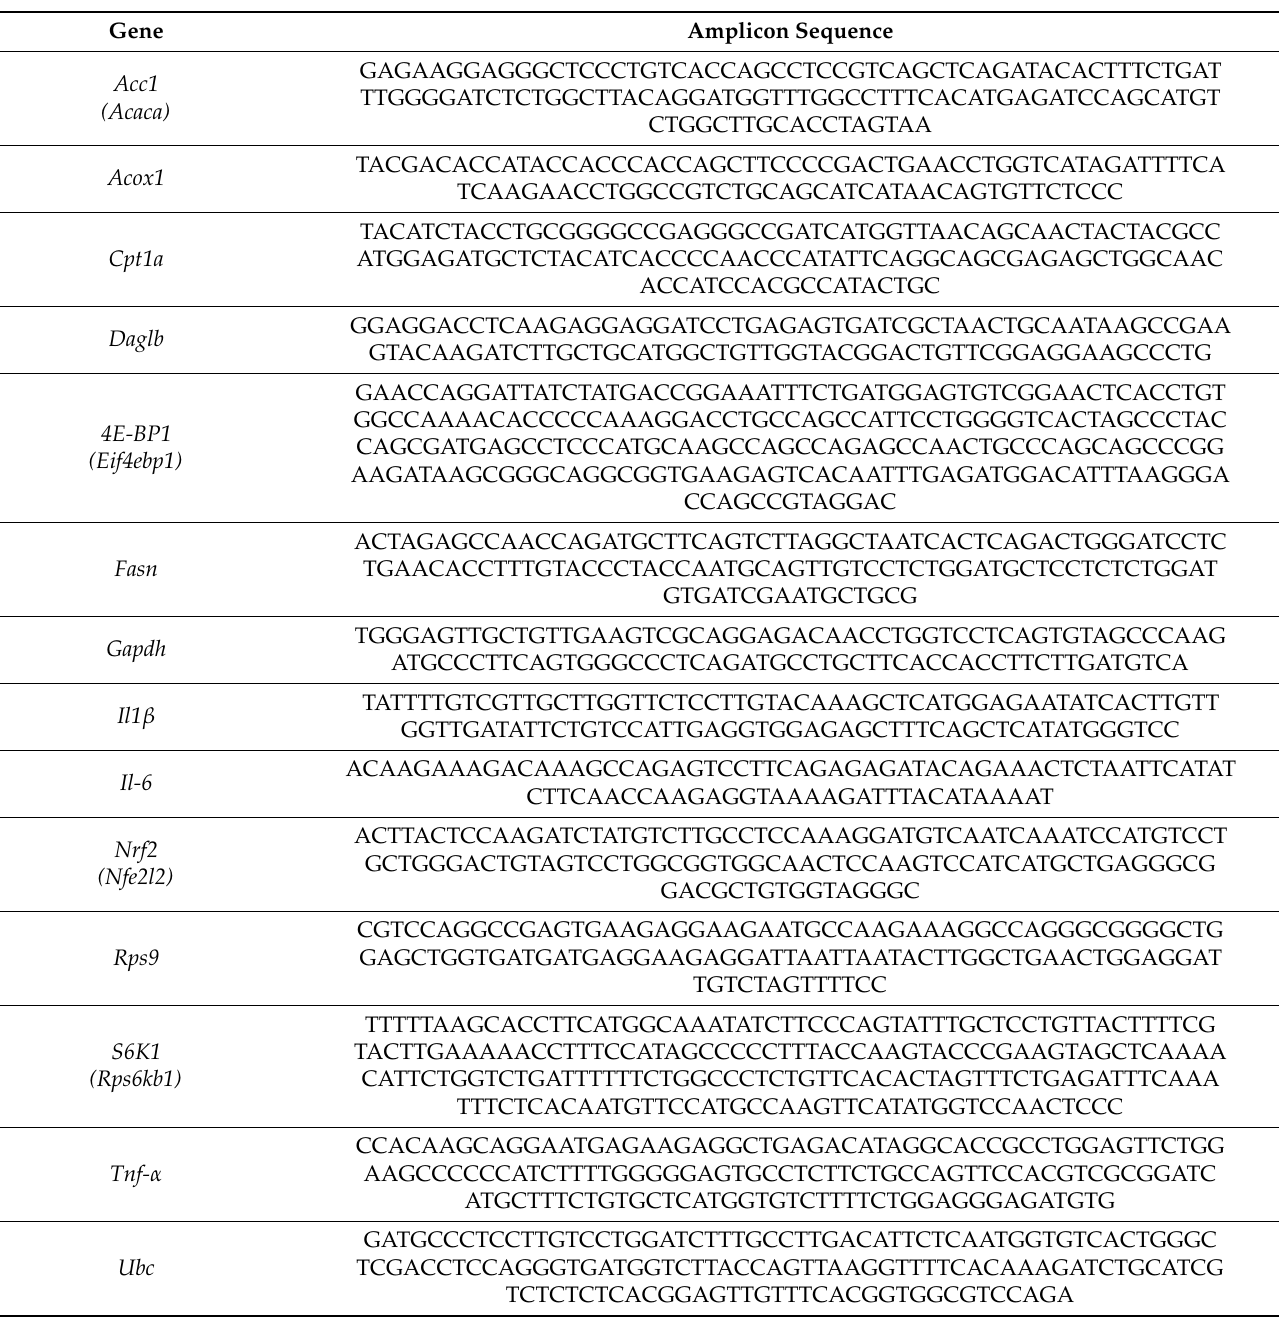
Table 2. Amplicon sequences of primers used in this study. Acetyl-Coenzyme A carboxylase alpha (Acc1 or Acaca); acyl-Coenzyme A oxidase 1, palmitoyl (Acox1); carnitine palmitoyltransferase 1a, (liver isoform, Cpt1a); diacylglycerol lipase, beta (Daglb); eukaryotic translation initiation factor 4E binding protein 1 (4E-BP1 or Eif4ebp1); fatty acid synthase (Fasn); interleukin 1 beta (Il1 β ); interleukin 6 (Il-6); nuclear factor (erythroid-derived 2)-like 2 (Nrf2 or Nfe2l2); ribosomal protein S6 kinase, polypeptide 1 (S6K1 or Rps6kb1) and tumor necrosis factor alpha (Tnf- α ) were the genes of interest to be analyzed. Glyceraldehyde-3-phosphate dehydrogenase (Gapdh), ubiquitin c (Ubc), and ribosomal protein S9 (Rps9) were used as reference